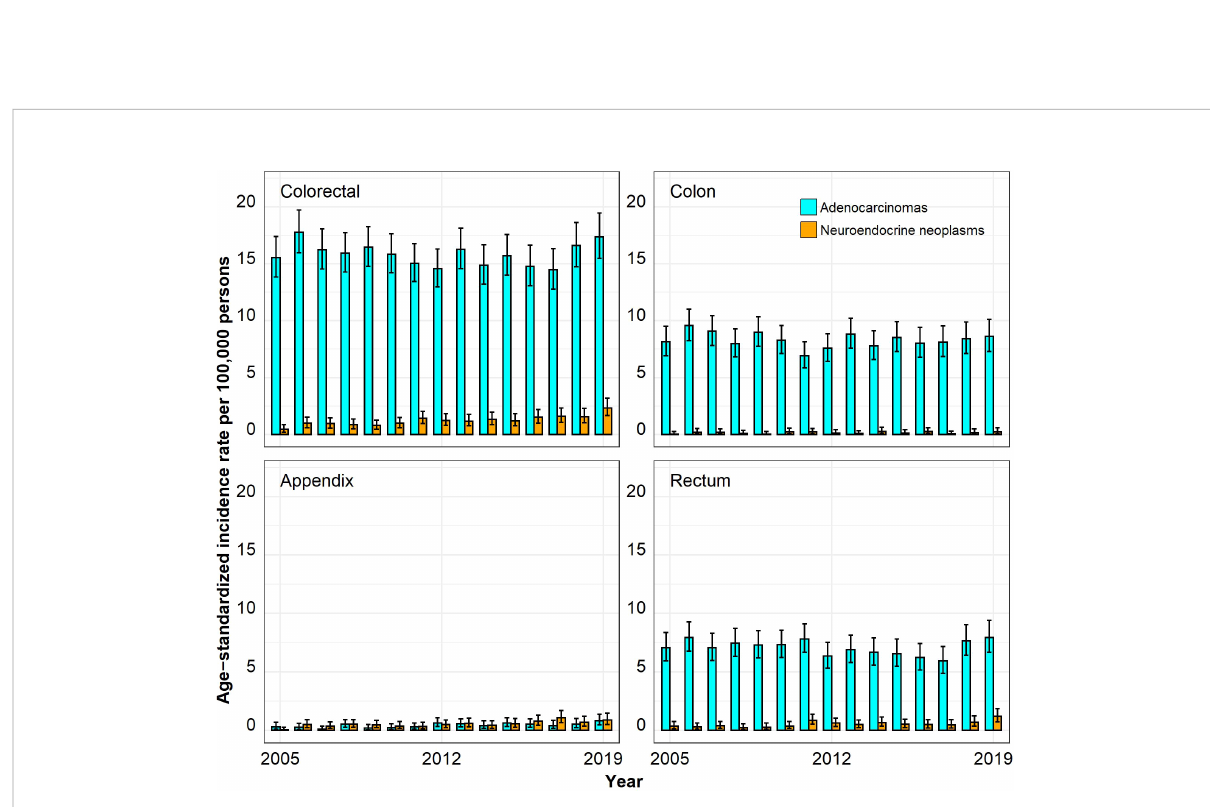
FIGURE 3 Annual age-standardized incidence rates per 100,000 persons for the age group 40 – 49 years by anatomic site and histological subgroup in Bavaria, 2005 – 2019. Error bars show 95% con fi dence